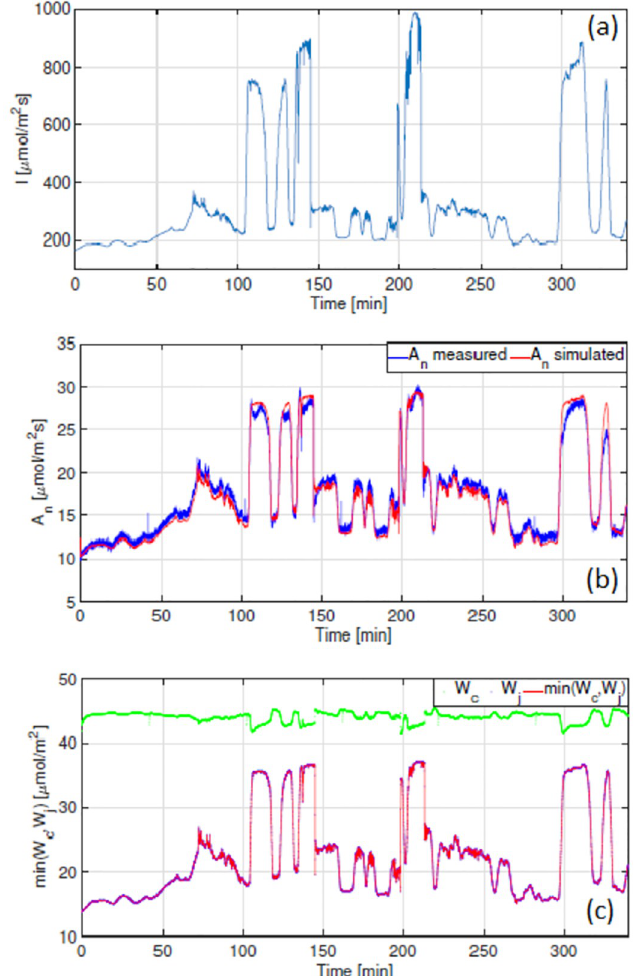
Fig 8. Model validation results obtained for measurements taken on 7 Sept 2021 with c a = 800ppm. (a) Measured irradiance μmolm − 2 s − 1 . (b) Net photosynthetic rate μmolm − 2 s − 1 (c) min(W photosynthesis is limited by the carboxylation or electron transport